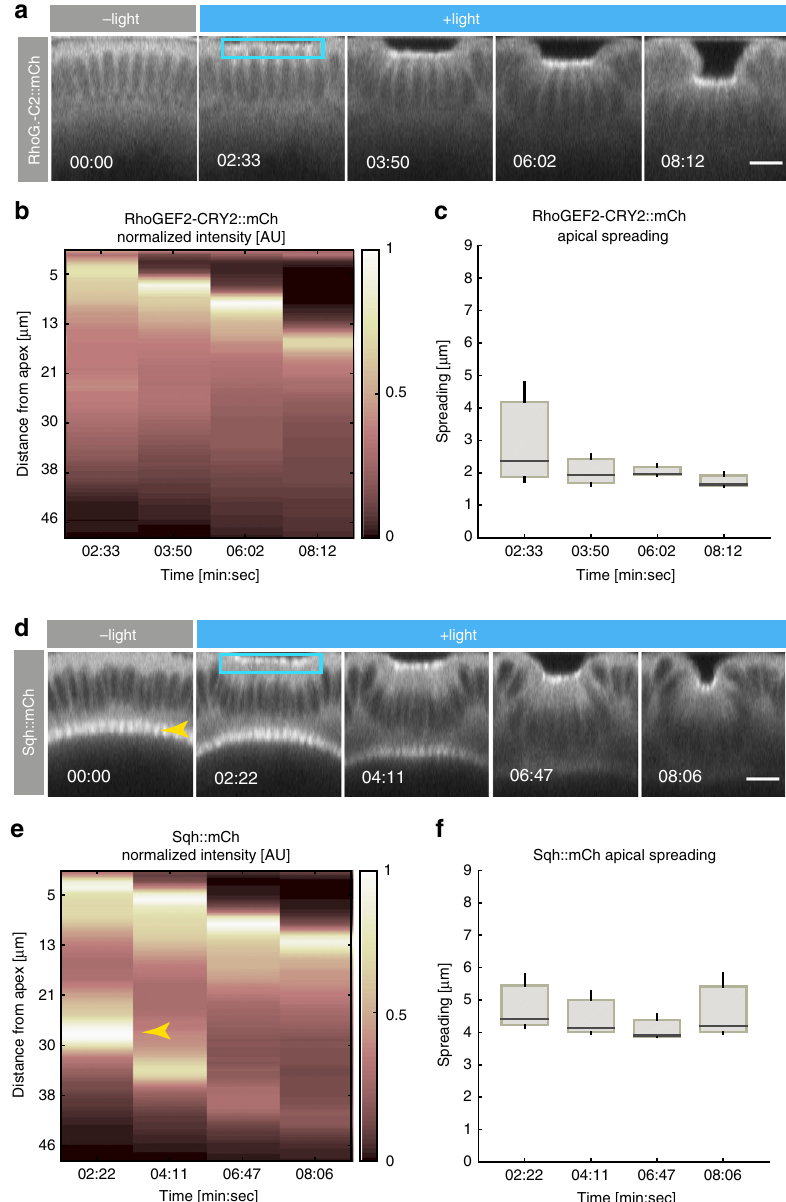
Fig. 6 Spatial precision of photo-activation (z-spreading). a , d Confocal still frames from a time-lapse recording of representative embryos ( N = 6) co- expressing a CIBN::pmGFP, RhoGEF2-CRY2::mCherry, or ( d ) CIBN::pmGFP, RhoGEF2-CRY2, and Sqh::mCherry (myosin II). A rectangular region (blue box) spanning 5 × 15 cells (XY plane) in three consecutive z-stacks (1 µ m spacing) centered at 4 µ m from the apical-most plane, was excited for ~228 ms for each acquisition round and alternated with mCherry excitation at intervals of 17 s. Images represents integrated intensity projections of 4 µ m of the mCherry signal along the transversal cross-section. Scale bars are 10 µ m. b Kymograph of RhoGEF2-CRY2::mCherry recruitment along the apico-basal axis of photo-activated cells and ( c ) spreading along the apico-basal axis measured by the Full Width at Half Maximum (FWHM) obtained from Gaussian fi tting of the apical intensity signal peak ( N = 3 embryos). d Confocal still frames from a time-lapse recording of a representative embryo co-expressing CIBN:: pmGFP, RhoGEF2-CRY2, and Sqh::mCherry. e Kymograph of Sqh::mCherry accumulation along the apico-basal axis and ( f ) myosin II accumulation and spreading along the cells ’ apico-basal axis measured by the FWHM obtained from Gaussian fi tting of the apical intensity signal peak ( N = 3 embryos). Yellow arrowhead in d and e indicates myosin-II at the basal surface of the